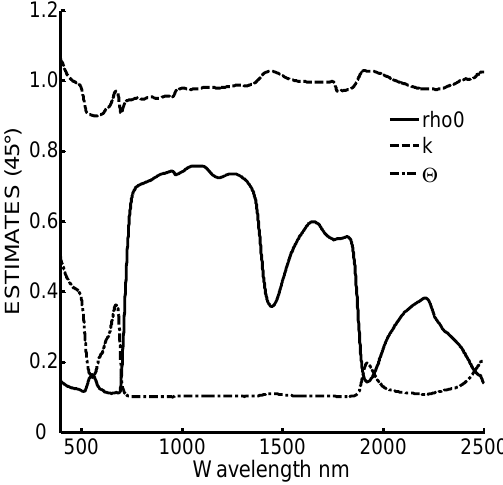
Figure 3. The RPV model parameters rho0, k, and Θ for all wavelengths, are presented for the eight BRF measurements with light source at